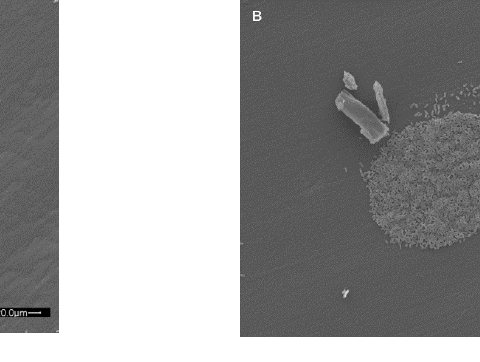
Figure 4. Scanning electron micrograph of bacteria associated with a single microarrayed spot of capture antibody. Live E. coli O157:H7, at two initial concentrations of 10 5 CFU/mL ( A ) and 10 8 CFU/mL ( B ) captured by array-printed antibodies (non-biotinylated anti- E. coli O157:H7 antibody) passively adsorbed to polystyrene well bottoms of a microtiter plate. Prior to SEM analysis, the BSA blocked plates were centrifuged (3220 × g for 5 min) to promote capture of bacteria (The scale bar is 20.0 µm in length).